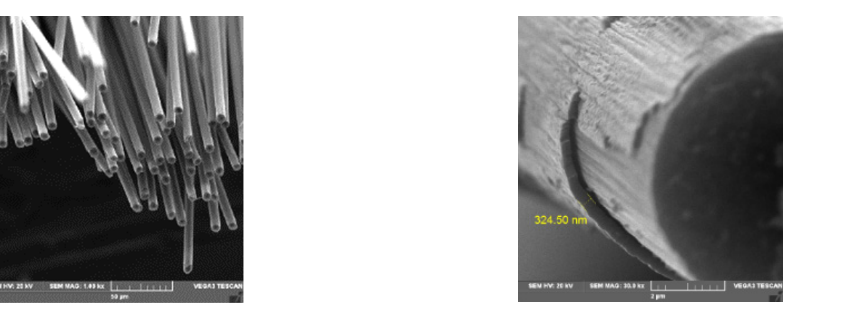
Figure 8. Metal-coated carbon fiber SEM measurement. The electromagnetic shielding ( SE ) test method of the nickel-coated carbon fiber pro- duced in this way was measured according to ASTM D4935 [21,22]. The electromagnetic